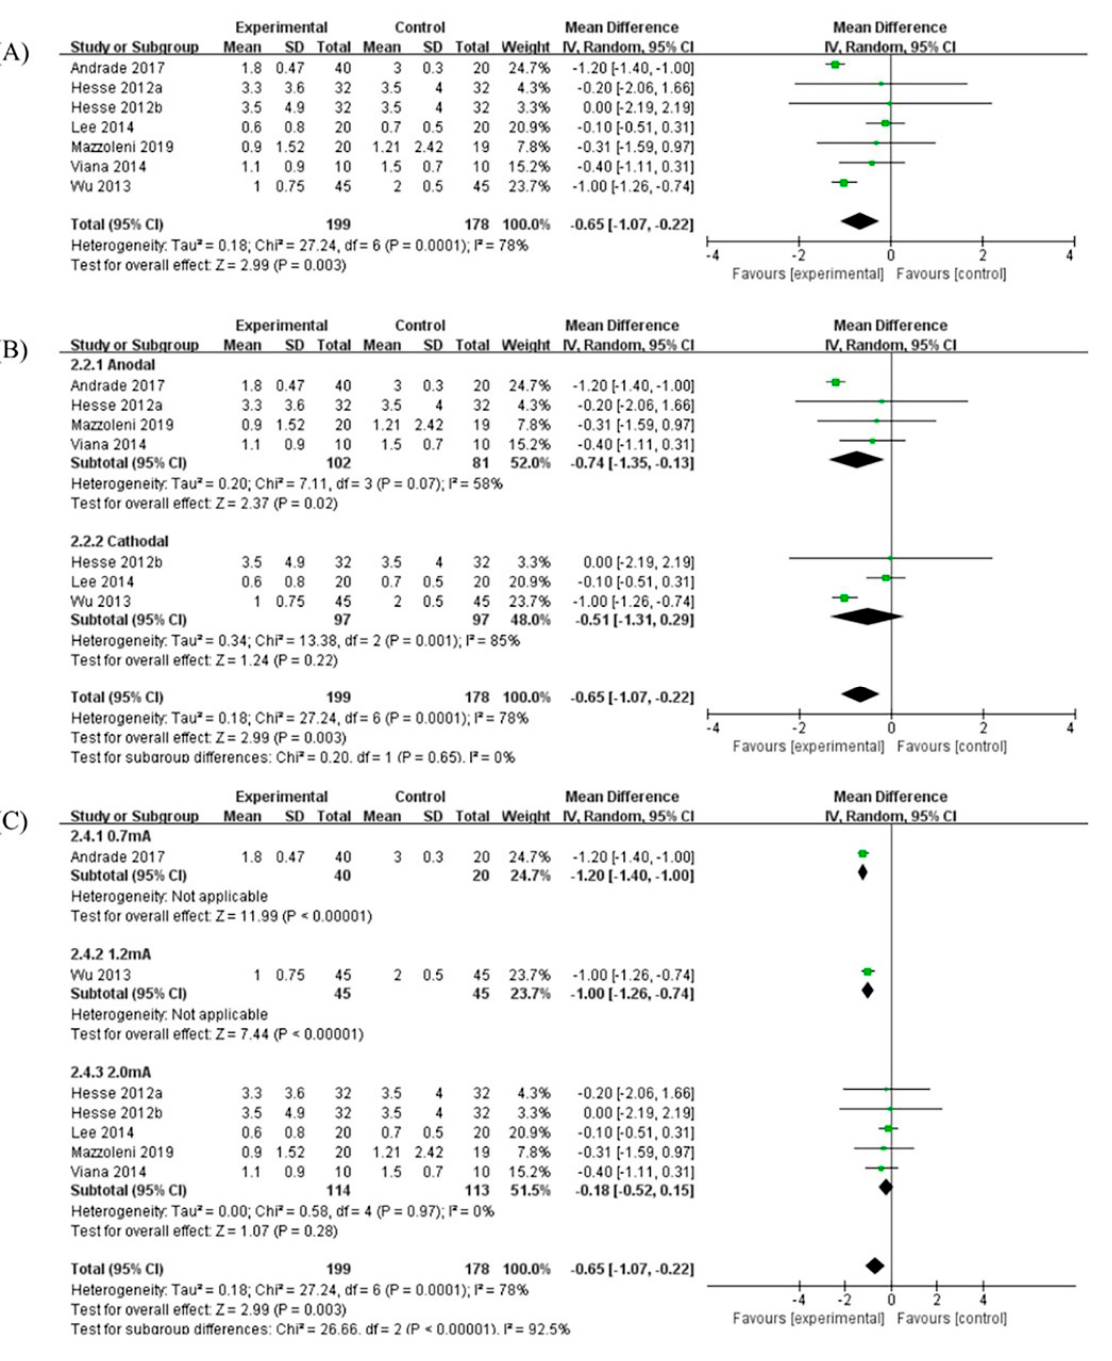
Figure 3. ( A ) Forest plot analysis of the effect of tDCS on post-stroke spasticity. ( B ) Forest plot analysis of the effects of different stimulation types for tDCS on post-stroke spasticity. ( C ) Forest plot analysis of the effects of different stimulation intensities for tDCS on post-stroke spasticity.